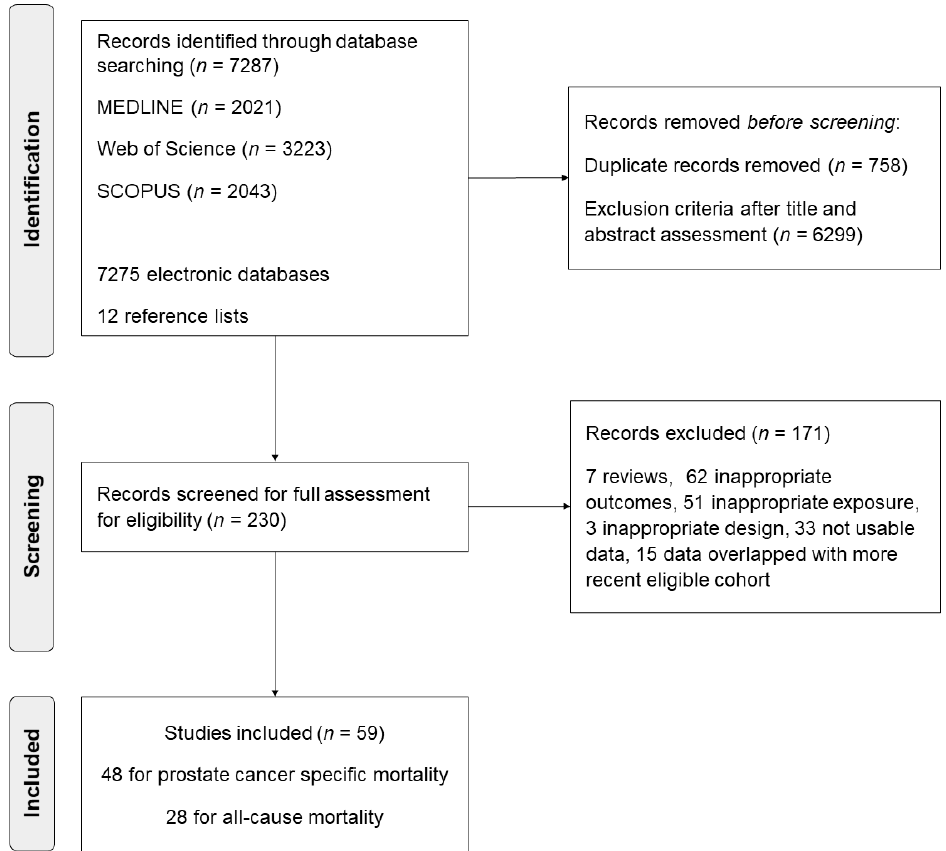
Figure 1. Study selection process in the systematic review and meta-analysis.